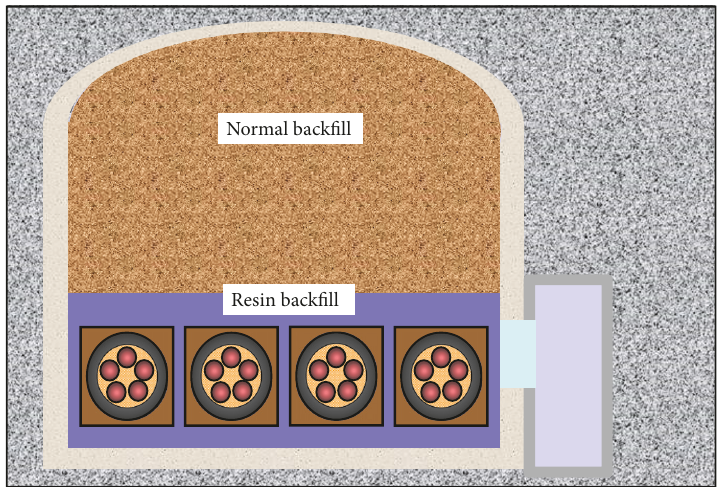
Figure 5: MPCs enclosed in prefabricated modules containing compacted bentonite buffer.